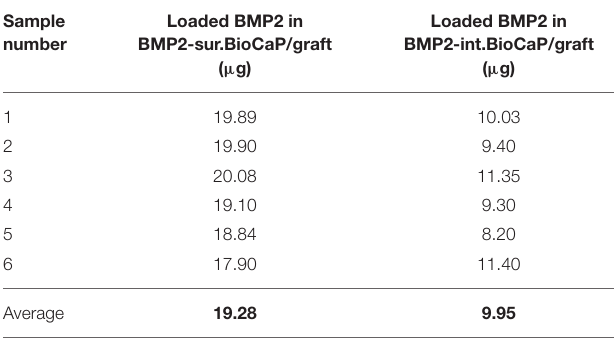
TABLE 2 | Amount of BMP2 loaded in two type of BMP2.BioCaP grafts. Sample